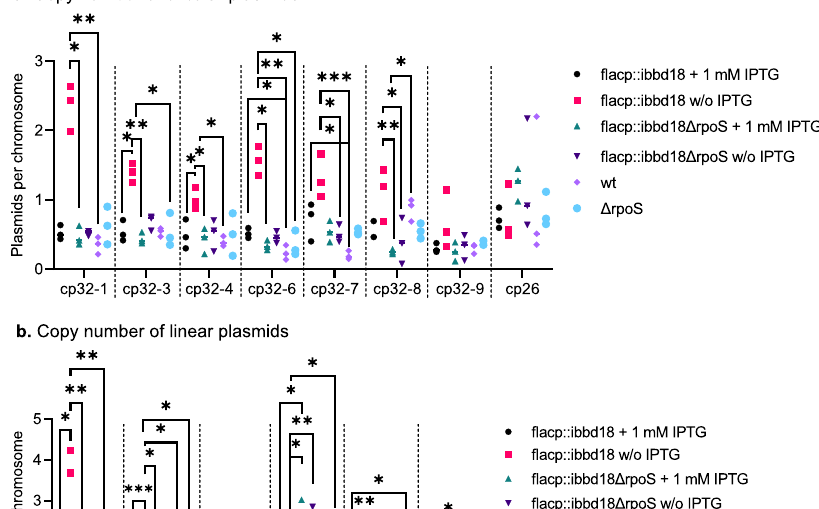
Fig. 5 | Depletion of BBD18 leads to increased replication and transcription of prophage plasmids. a , b Copy number of linear and circular plasmids. The cp32 and lp28-2 prophage plasmid copy numbers signi fi cantly increased only in fl ac- p::ibbd18whenculturedfor40hrsintheabsenceofIPTGandanalyzedwithDunn ’ s multiple comparison of the Kruskal-Wallis test. c Transcripts of the cp32-1, cp32-3,